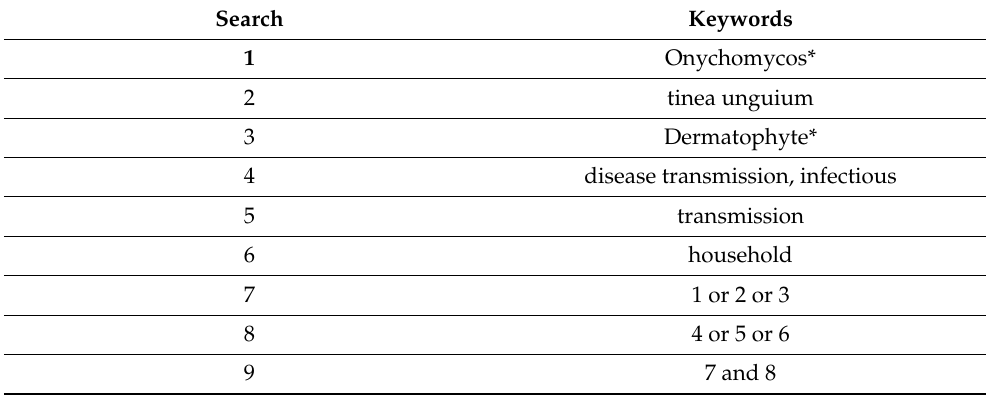
Table 1. MEDLINE search